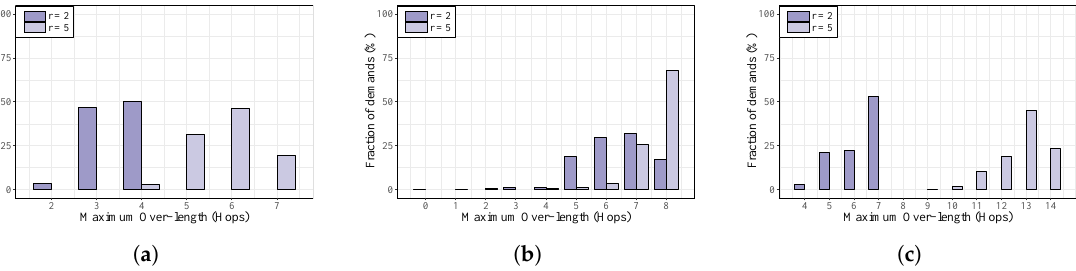
Figure 10. Distribution of maximum control traffic over-length for one controller under delay constraint in the: ( a ) New York topology; ( b ) Geant topology; and ( c ) Norway